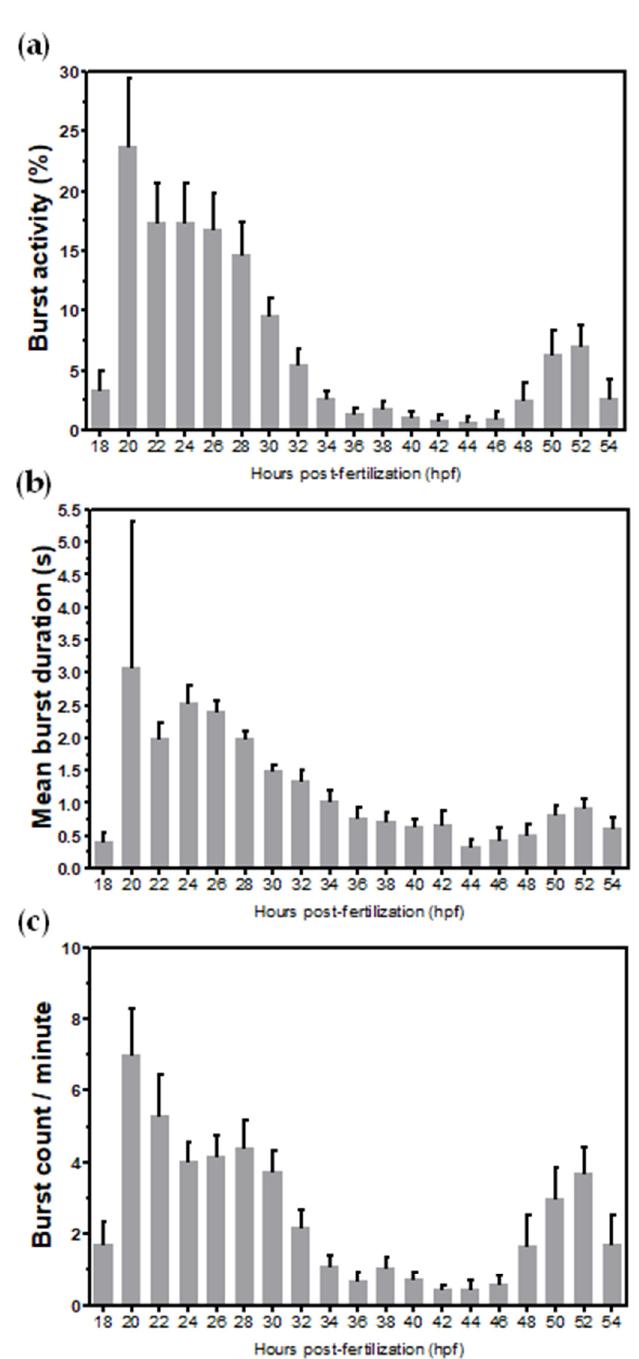
Figure 2. Monitoring of tail coiling activity throughout embryonic development from 18 to 54 h post-fertilization (hpf) at 2 h intervals. ( a ) Percentage (%) of burst activity; ( b ) mean burst duration (seconds); ( c ) burst count per minute. Statistical analysis was performed to test significant differences in coiling activity between different stages of development, and was tested by ANOVA on ranks (Kruskal–Wallis test) followed by the Dunn’s post-hoc test ( p ≤ 0.05). Significant differences between measurements are not represented in graphs—instead, they are detailed in Tables S1–S3. Each bar represents a different group of 80 embryos divided into two independent experiments. Values are expressed as means (bars) and 95% confidence intervals (error